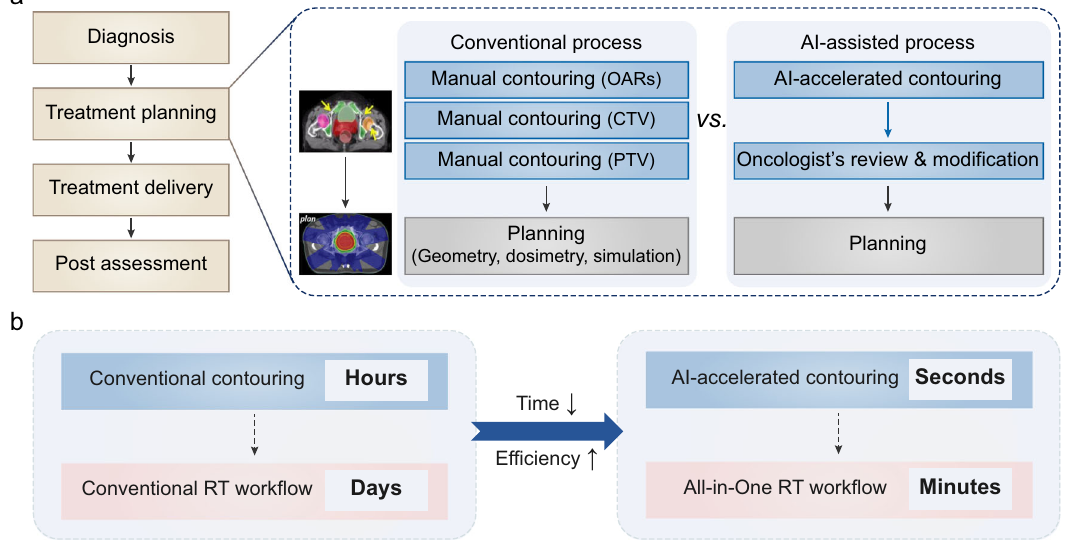
Fig. 1 | Arti fi cial intelligence (AI)-accelerated contouring promotes All-in-One radiotherapy (RT). a The process overview of conventional RT vs . AI-accelerated All-in-One RT. The RT work fl ow can be divided into four steps, in which